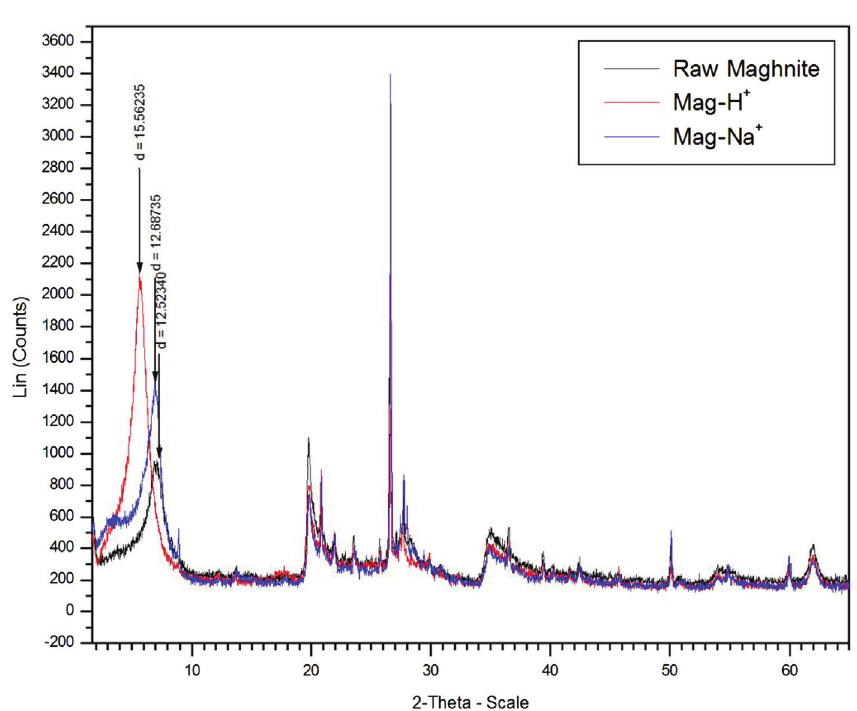
Figure 4: XRD spectra of raw maghnite, maghnite sodium and acidic